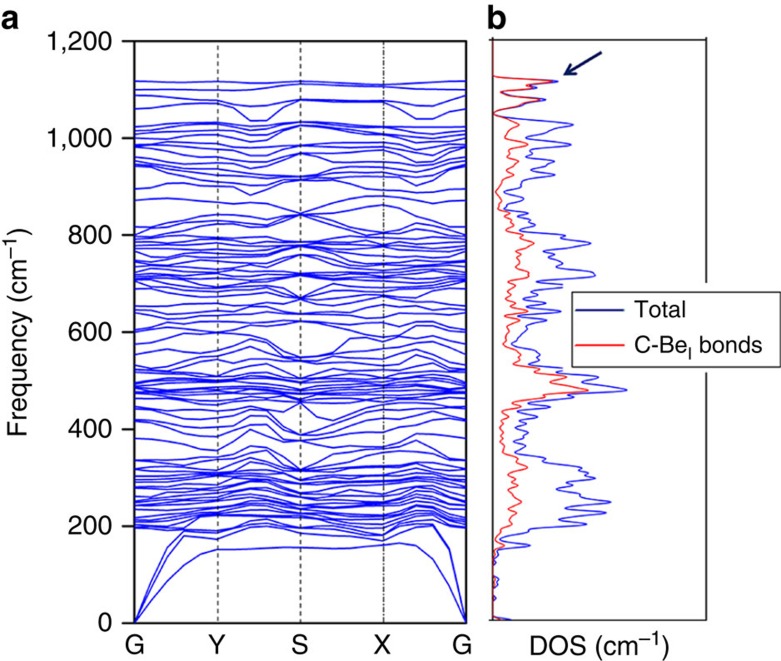
Kinetic stability of Be5C2 monolayer.(a) Phonon spectrum and (b) phonon DOS of Be5C2 monolayer.